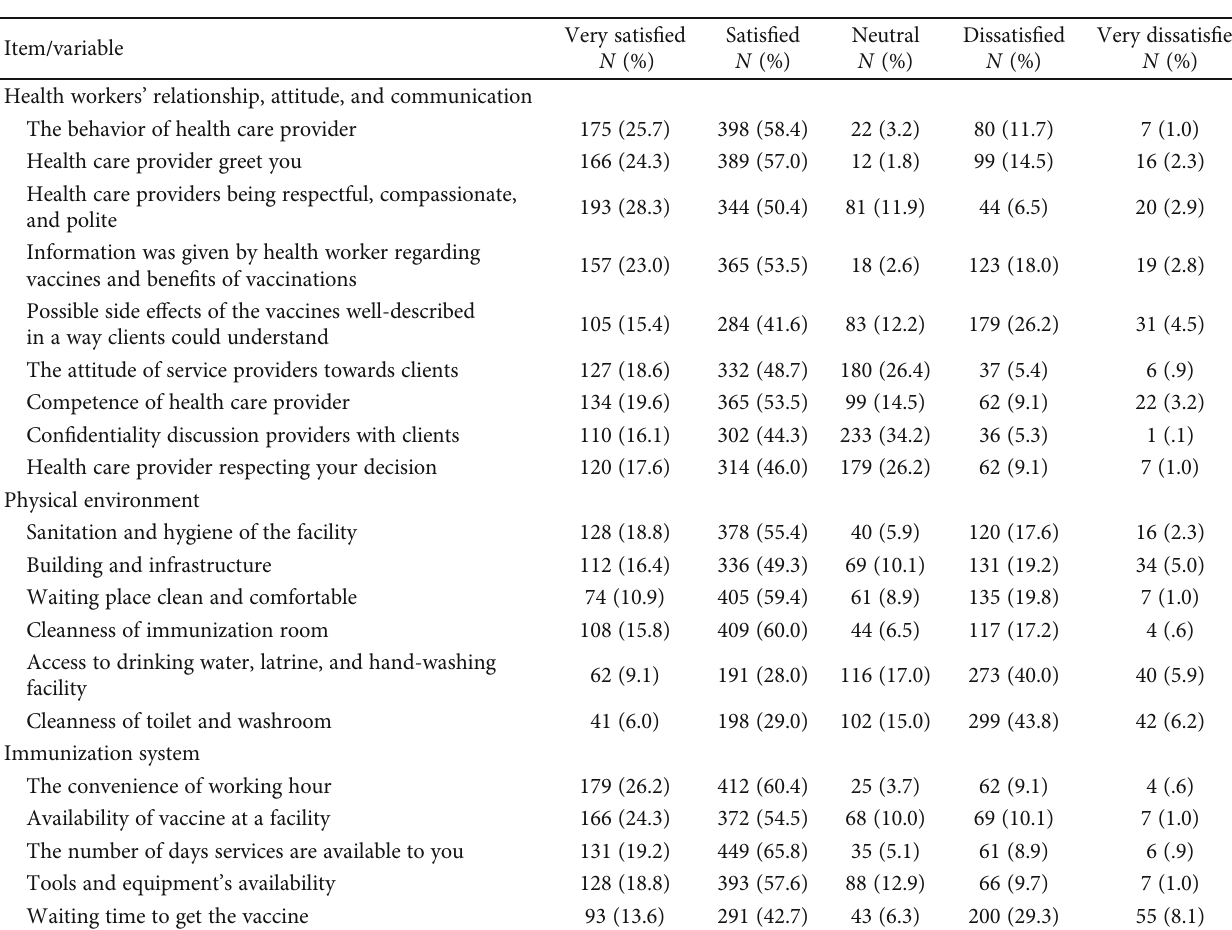
Table 4: Maternal satisfaction scores for respondents whose children receiving immunization service in Wadla district, North Wollo, Amhara regional state, northeast Ethiopia, 2019, n = 682